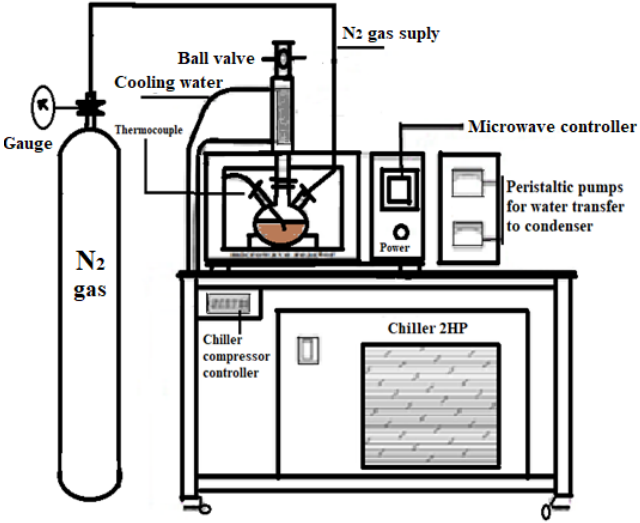
Figure 1 . Reactor set up for glycerol polymerization reaction . Figure 1. Reactor set up for glycerol polymerization